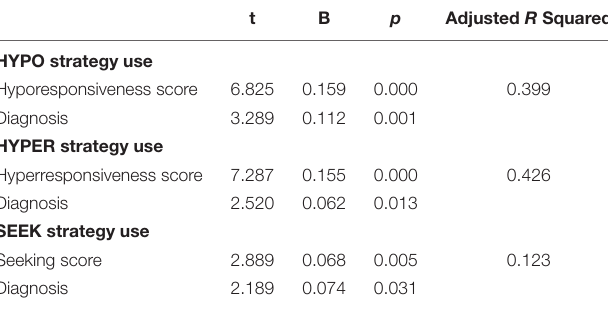
TABLE 1 | Participant demographics. Diagnostic group N % male Race/Ethnicity ASD